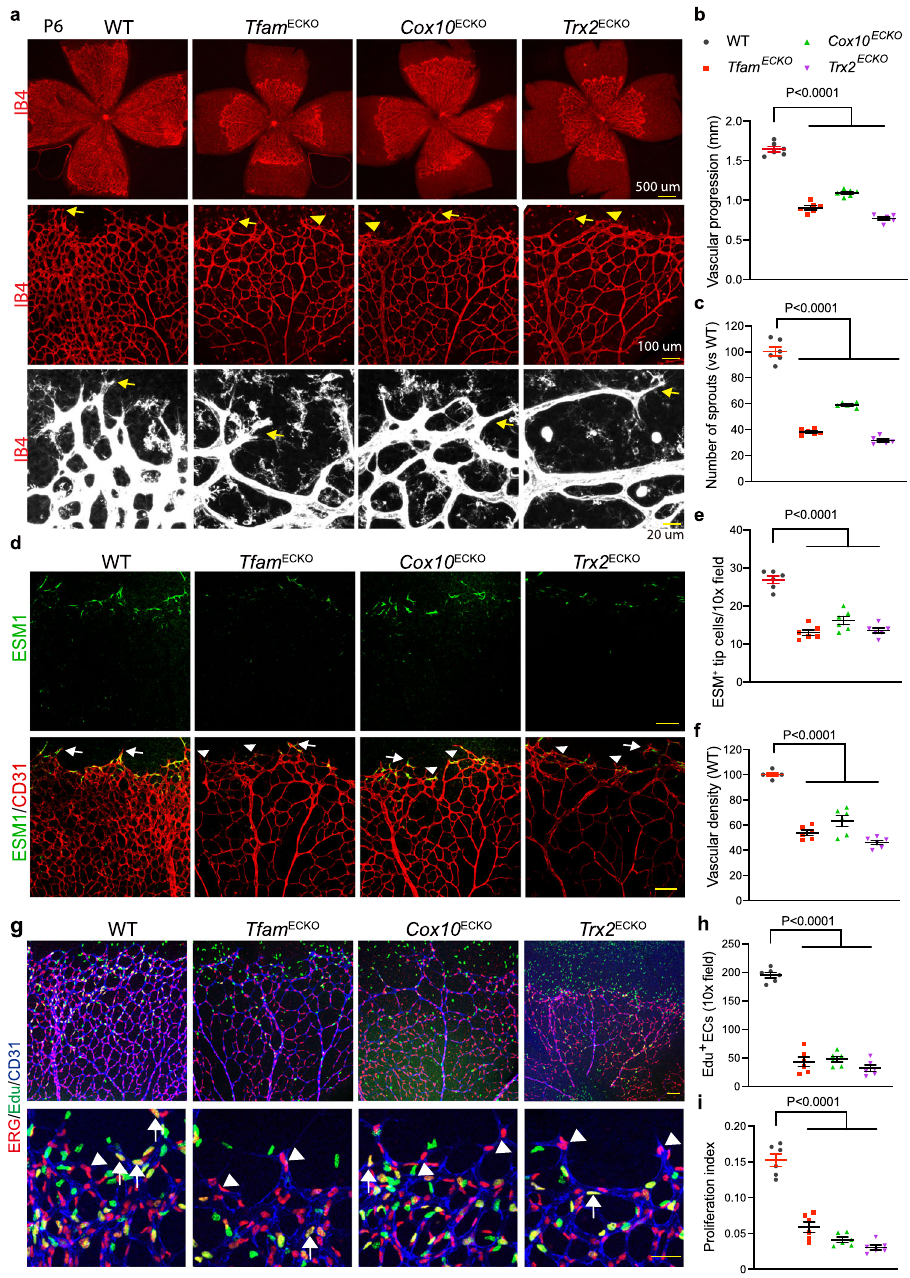
Fig. 3 | Mitochondrial activity is critical for retinal sprouting in mice. a – c P6 retinas from WT, Tfam ECKO , Cox10 ECKO and Trx2 ECKO were subjected to whole-mount staining for IB4. a Different power images are shown. Arrows and arrowheads indicate normal and defective sprouts, respectively. b – c Vascular progression (the distance of radial extension of the vascular plexus from the optic center) and number of sprouts was quanti fi ed. n =6 mice per group. d – f Visualization of tip cells. P6 retinasweresubjected to whole-mount staining for IB4with ESM1.Arrows andarrowheadsindicatenormalanddefectivetipcells,respectively.ESM1 + Tipcell number ( e ) and relative vascular density ( f ) were quanti fi ed. n =6 mice per group. g – i WT, Tfam ECKO , Cox10 ECKO and Trx2 ECKO were received intraperitonealinjectionof